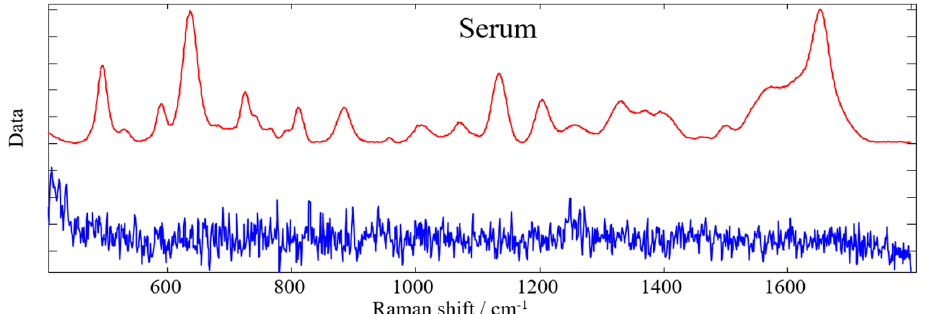
Figure 2. SERS spectrum (red) of the blood serum sample from a normal subject (HC) obtained by mixing the serum sample with AgNPs colloids in a 1:1 ratio, and the regular Raman spectrum (blue) of the same blood serum sample without the AgNP colloids. Spectra were recorded under the same conditions for comparison.